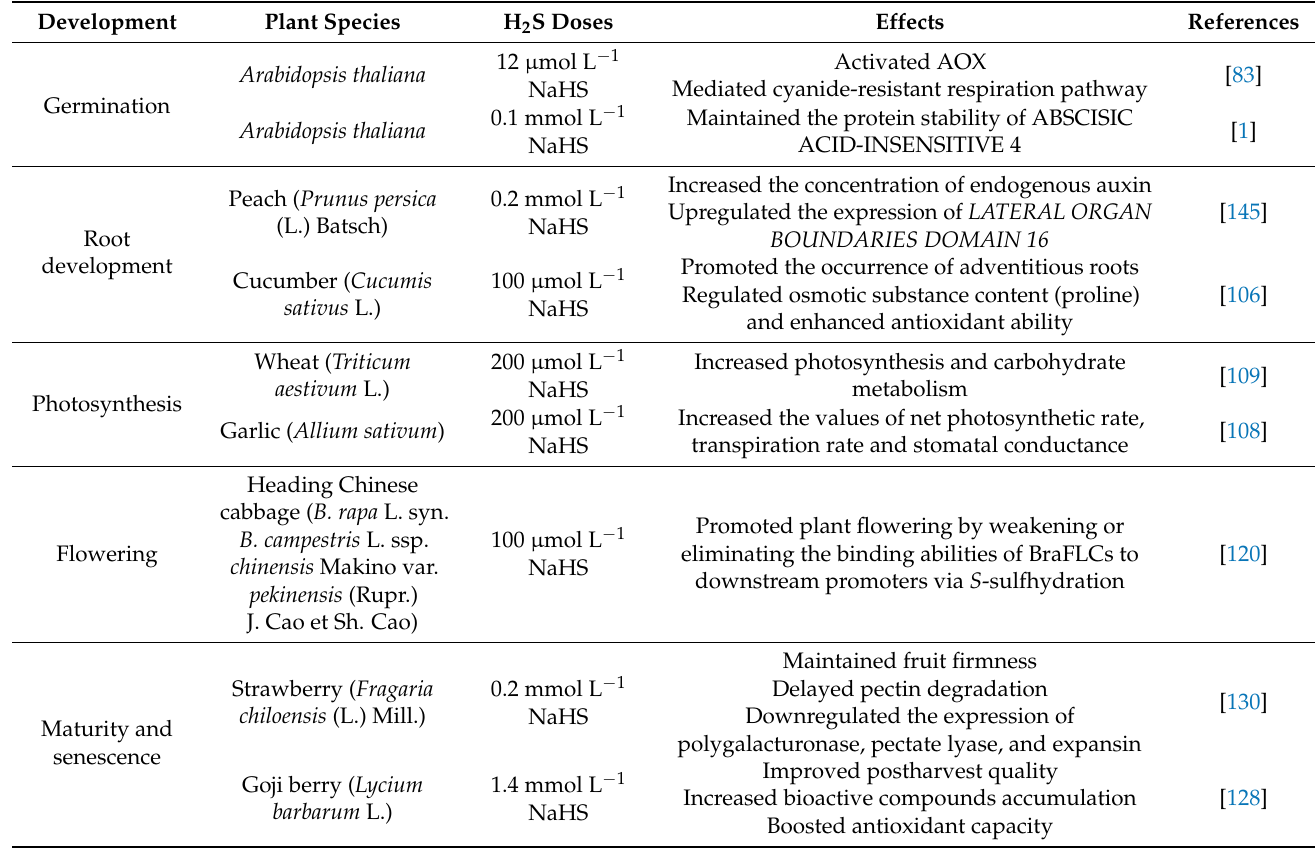
Table 1. H 2 S is involved in plant growth and